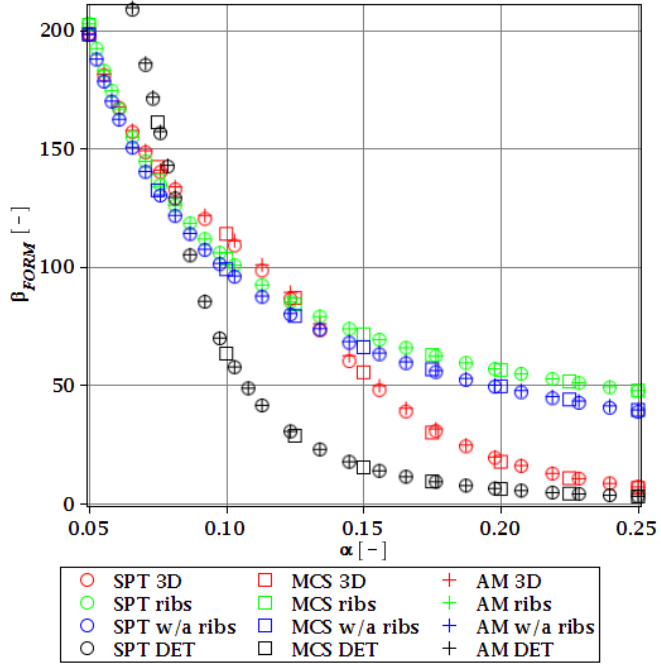
Figure 18. Reliability index of the corrugated I-beam for three ABAQUS models according to FORM and based on the deflection.